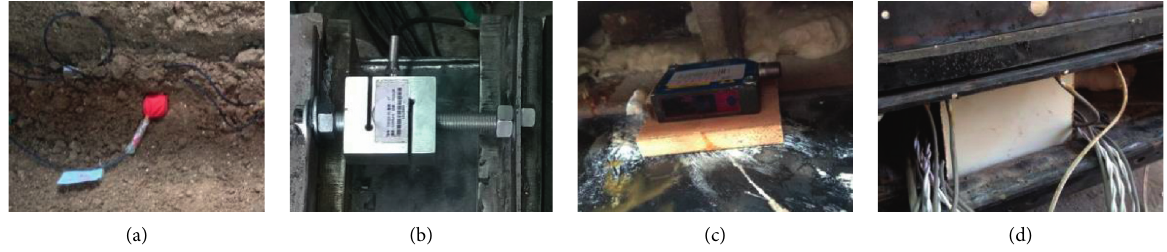
Figure 9: Sensors. (a) Acceleration sensor. (b) Force sensor. (c) Laser displacement sensor. (d) Baffle of Laser displacement